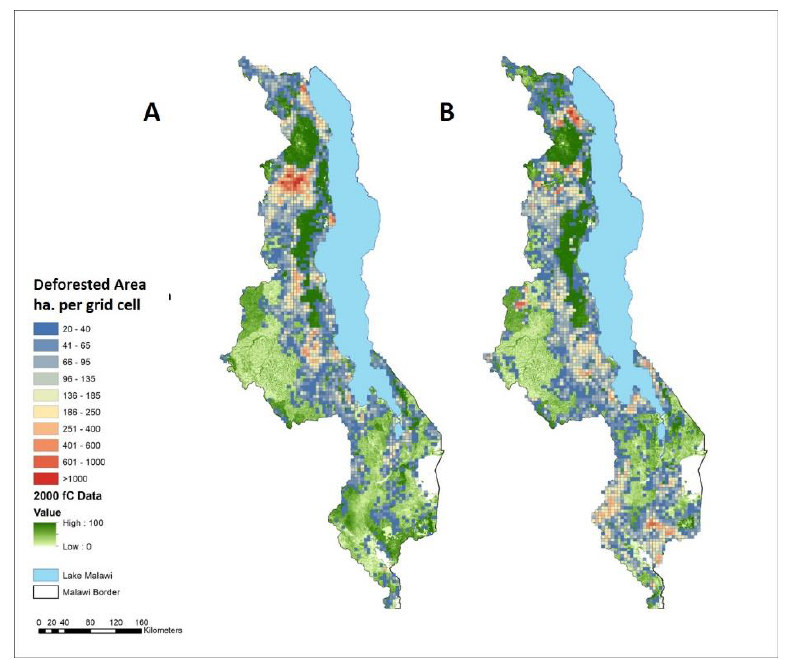
Figure 5. Mapped areas of deforestation, 2000 to 2009 ( A ) and 2010 to 2015 ( B ), as the area of total new deforested land (ha) created during the period within each 25 km 2 grid cell. Cells where deforested area is <20 ha are not shown.